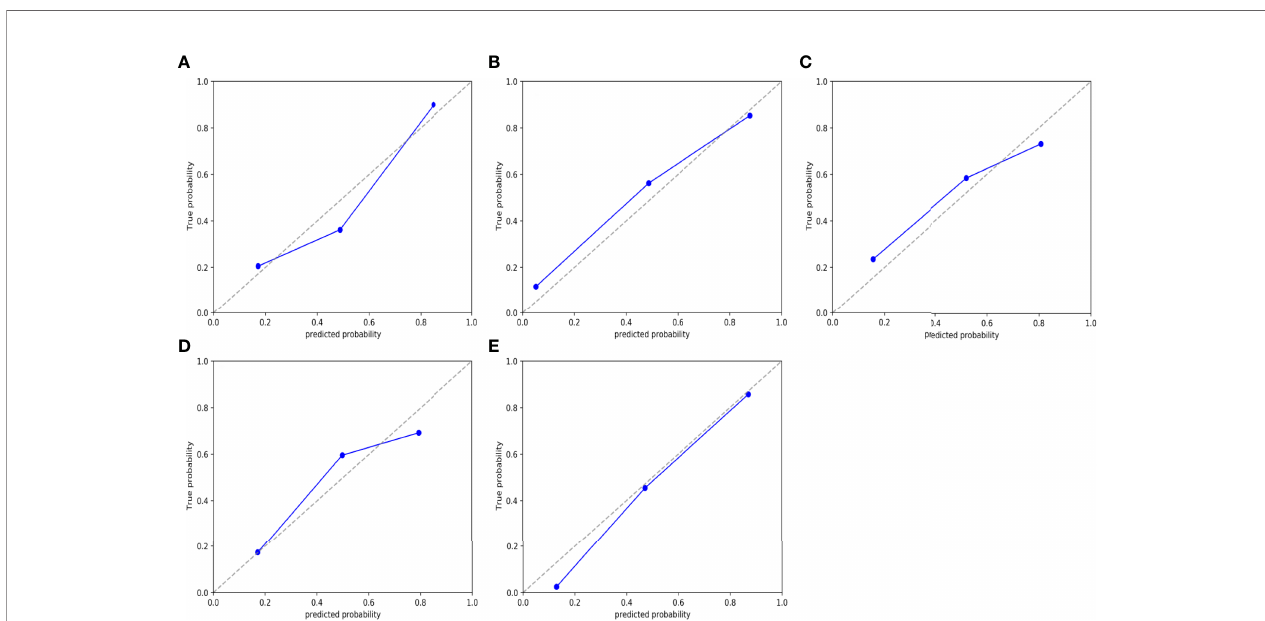
FIGURE 6 | Calibration curves of the nomogram model in validation cohort. (A) type. (B) grade. (C) DMI. (D) LVSI. and (E) LNM. The 45° dotted line represents the ideal prediction, while the blue line represents the prediction performance of the nomogram. The closer the blue line is to the dotted line, the better the performance of the